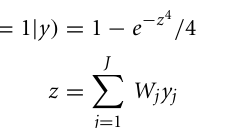
Frontiers in Neurology | Sleep and